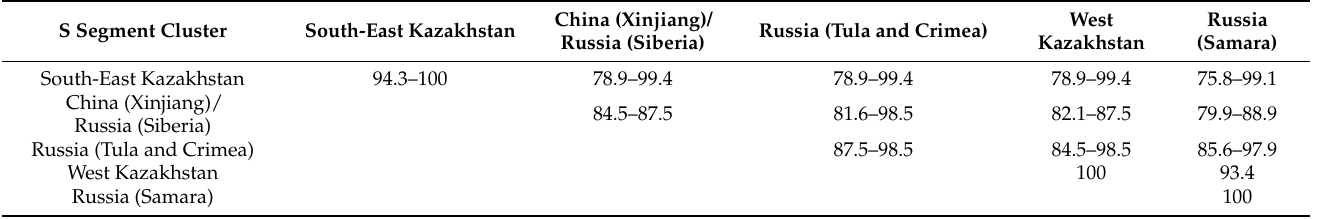
Table 3. Nucleotide sequence identity of the partial Tula virus (TULV) S-segments detected from Kazakhstan in comparison with published sequences from other Eurasian regions (%).